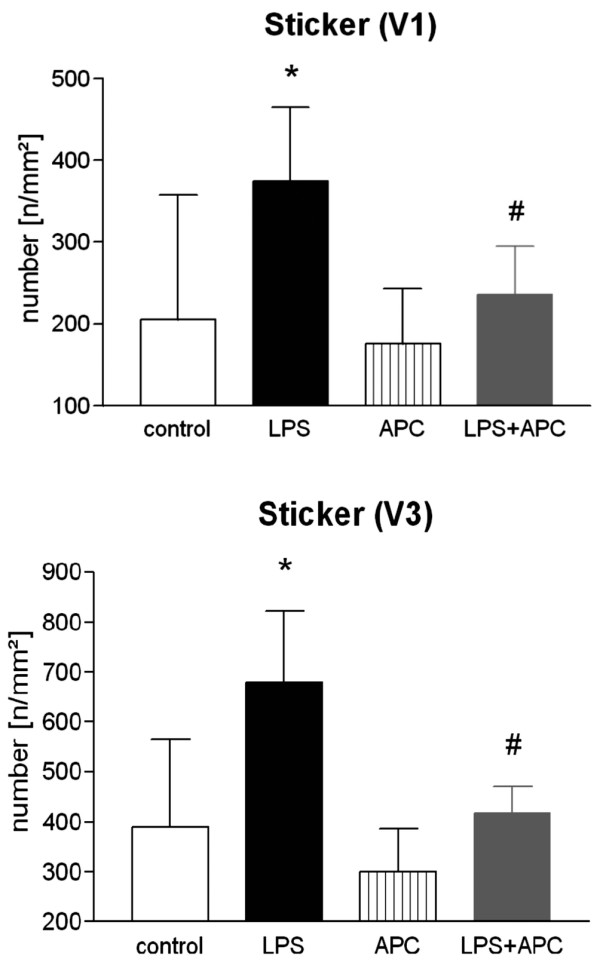
Number of closely adherent leucocytes (sticker) in V1 (a) and V3 (b) venules. *p < 0.05 versus control; #p < 0.05 versus LPS. APC, activated protein C-only group; LPS, lipopolysaccharide-only group; LPS + APC, activated protein C-treated endotoxaemic group.